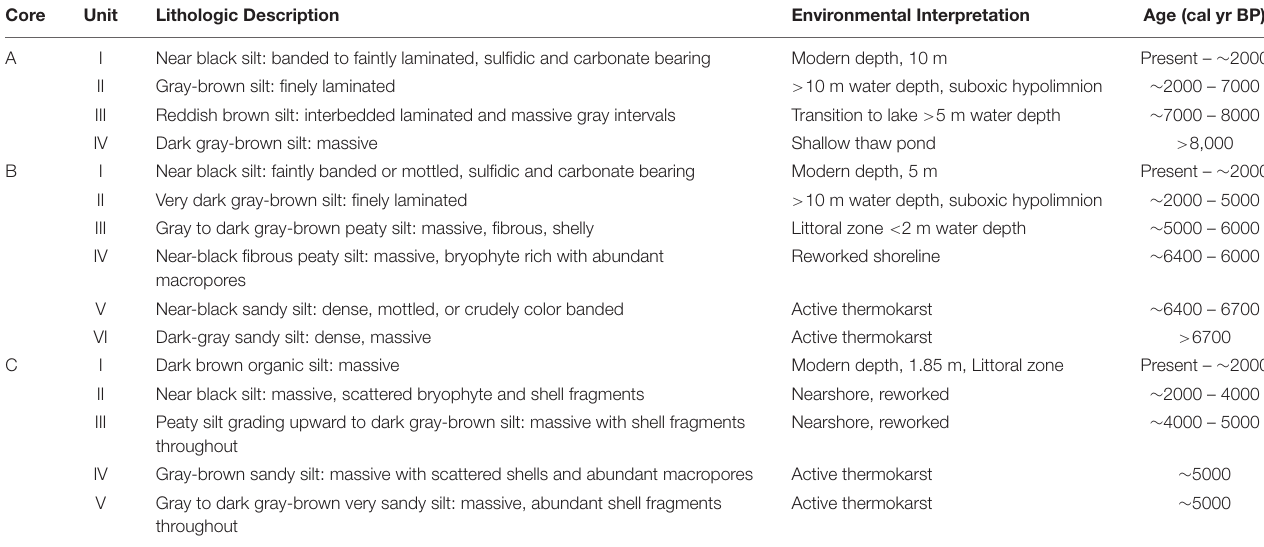
TABLE 4 | Greenpepper Lake sediment core lithology, interpretation, and estimated ages.